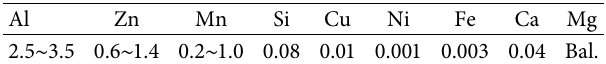
Table 1: Main chemical composition of AZ31B magnesium alloy (mass fraction,%).